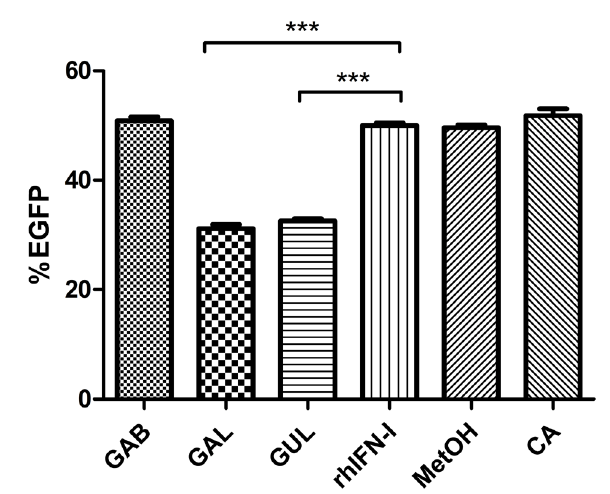
FIGURE 6 - Effect of Gauchito (GA) and Gurí (GU) extracts on the rhIFN-I activity evaluated by WISH-Mx2/EGFP RGA. The effect of each GA and GU extract was evaluated on the rhIFN-I activity trough a specific RGA and their effects were compared with the vehicle (MeOH, Control), chlorogenic acid (CA, 10 µg/mL) and human recombinant IFN type I (rhIFN-I control). Dilution 1:100 of extracts in MeOH (40 µg/mL) of GA or GU leaf extracts (GAL and GUL) and GA bract (GAB). The asterisks indicate the existence of a significant difference between the extracts and the positive control assay (rhIFN-I), (** p < 0.01 and *** p < 0.001 ANOVA statistical test followed by Bonferroni’s post- test was